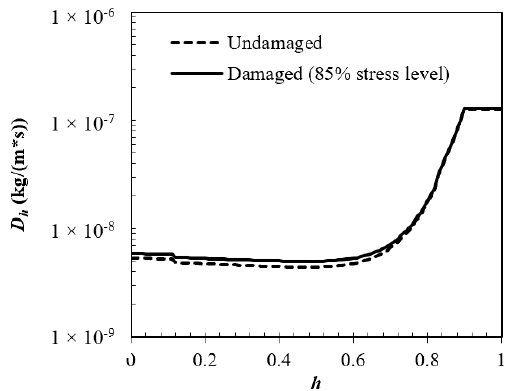
Figure 11. Moisture diffusivity of undamaged and damaged